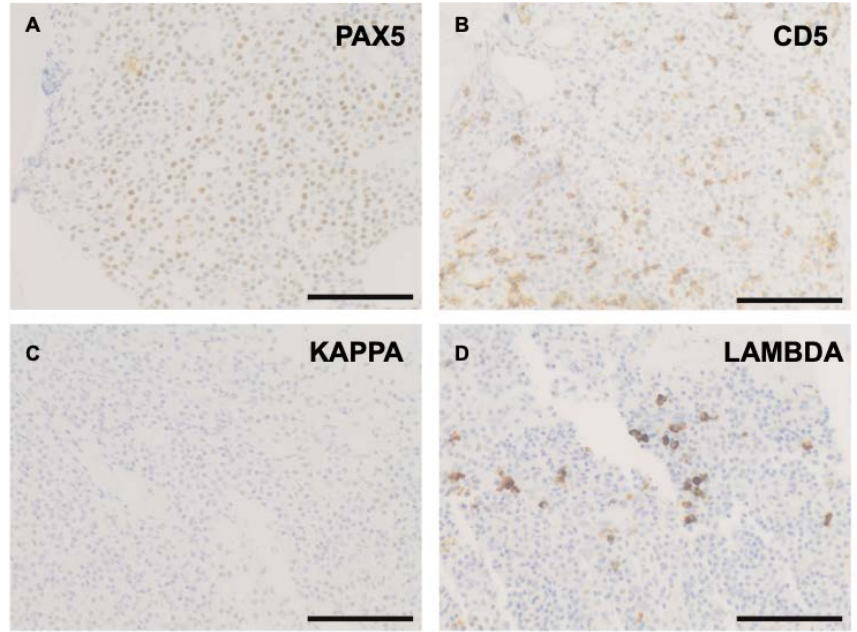
Figure 2. Immunohistochemistry of the initial bone marrow biopsy showing the lymphoplasmacytic lymphoma to be positive for Pax5 ( A ) and negative for CD5 ( B ) with a plasmacytic component negative for kappa ( C ) and positive for lambda ( D ). (Scale bars = 50 µm at magnification 400×).